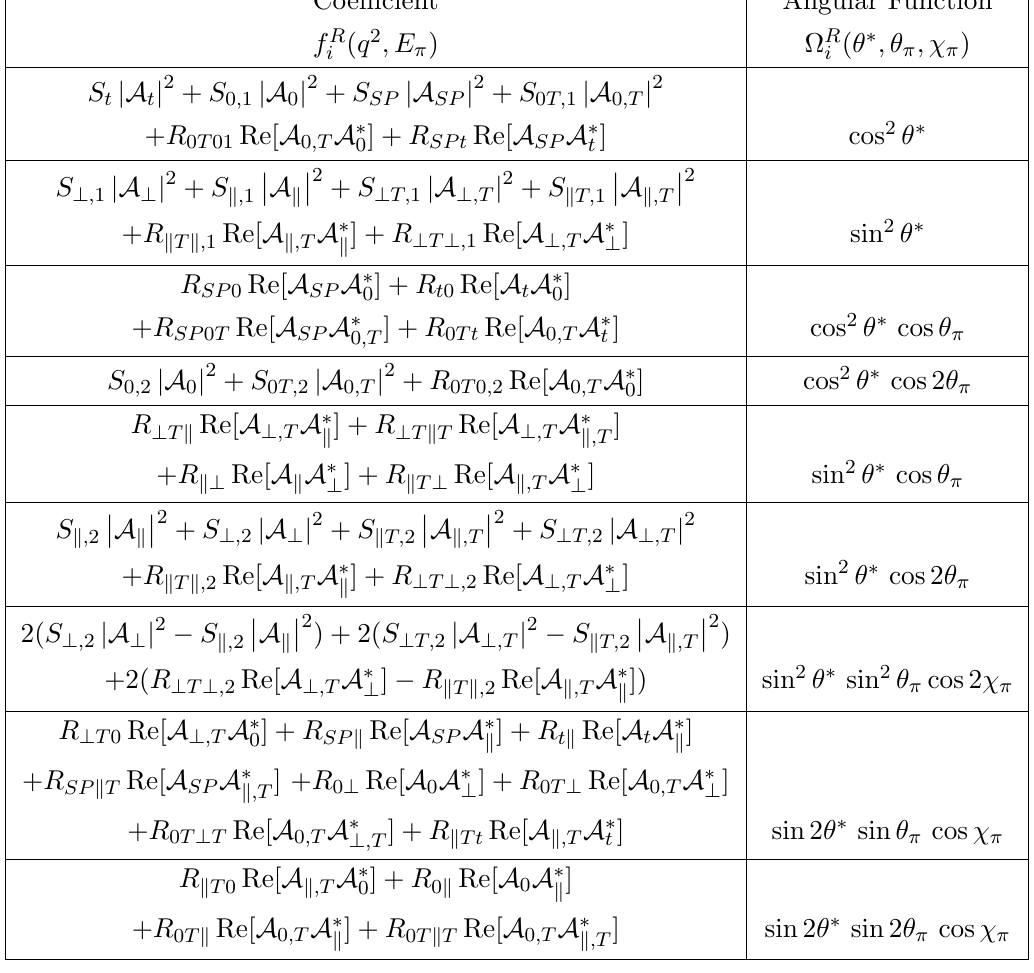
jA i j 2 and N R Re[ A i A (cid:3) ] [eq. (2.15)] to the angular distribution. i i;j j